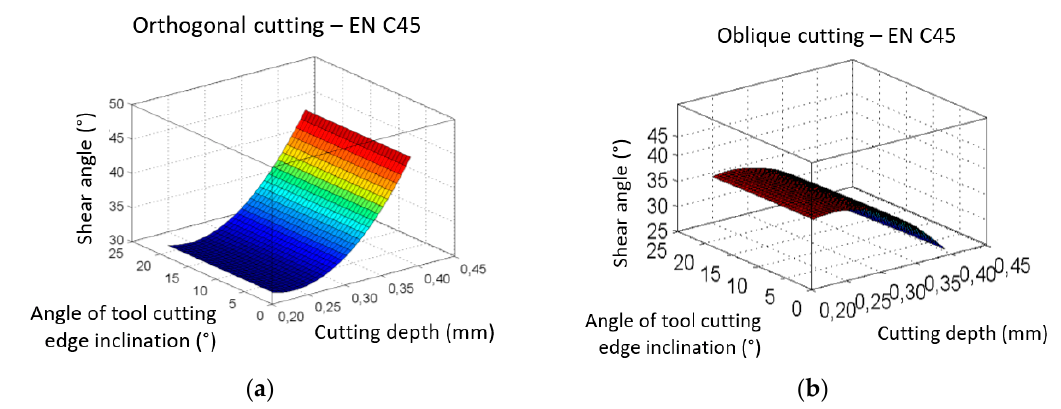
Figure 16. The dependence of shear angle Φ on cutting depth a p and on the angle of tool cutting edge inclination λ s ; ( a ) orthogonal cutting; ( b ) oblique cutting.